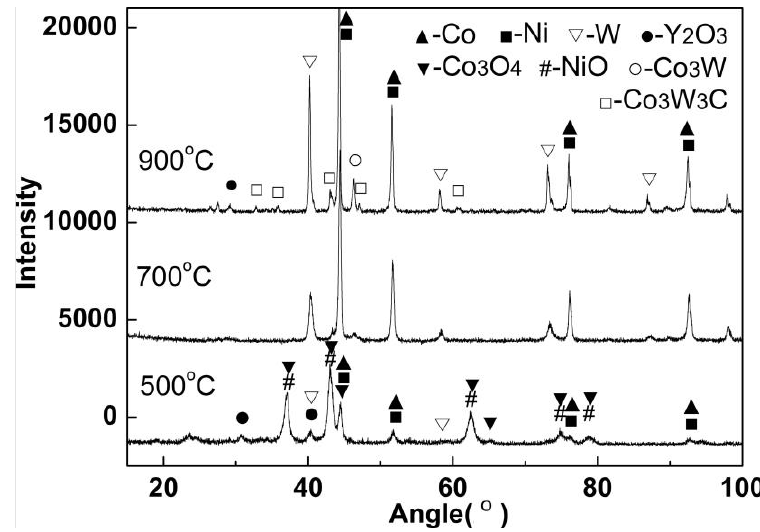
Figure 8. XRD patterns of the powder reduced at the temperature range of 500 – 900 °C.